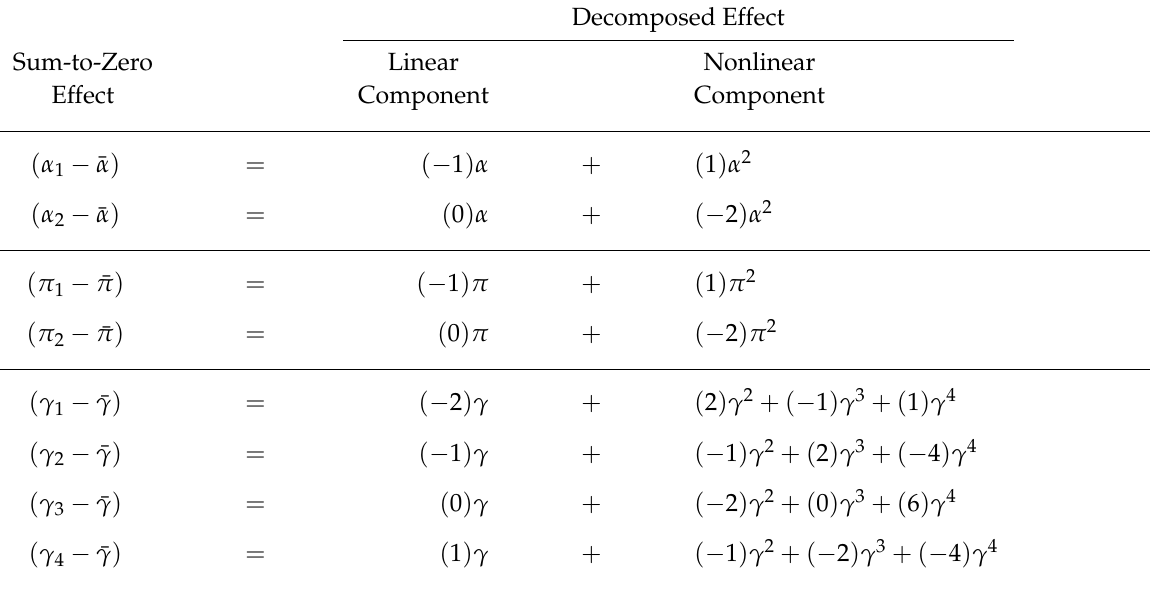
Table 2: Decomposition of sum-to-zero effects using the transformation